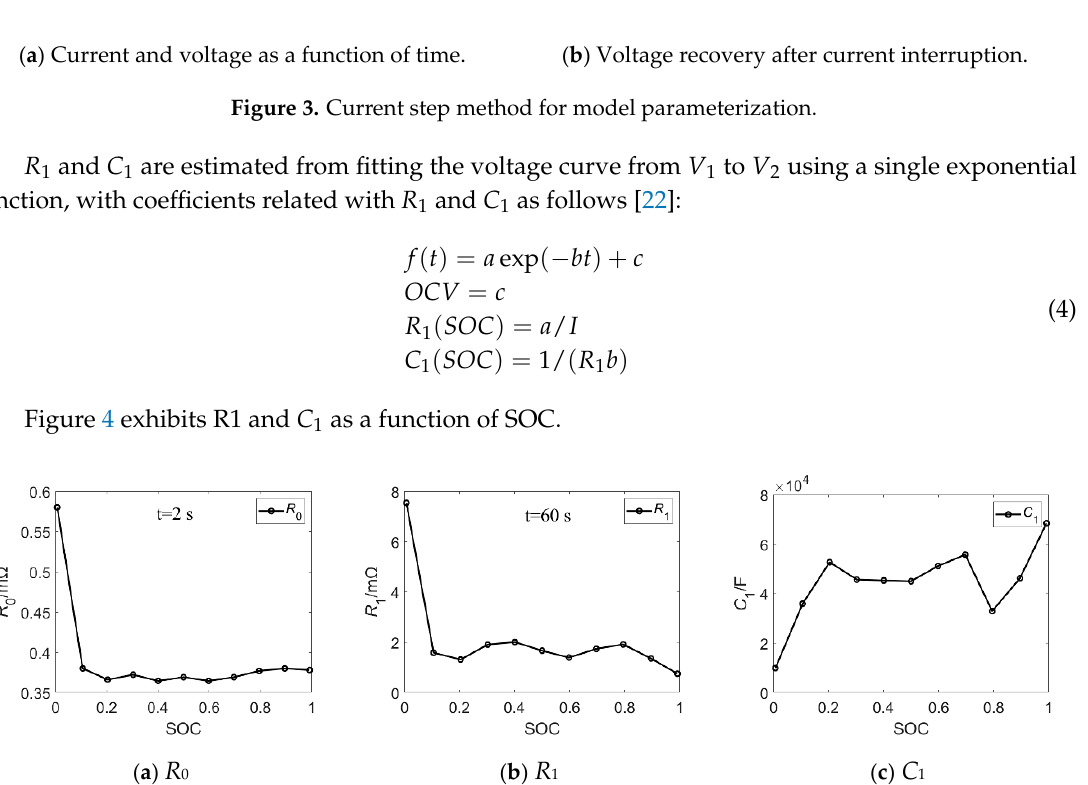
Figure 4. Model parameters of the battery module as a function of SOC.